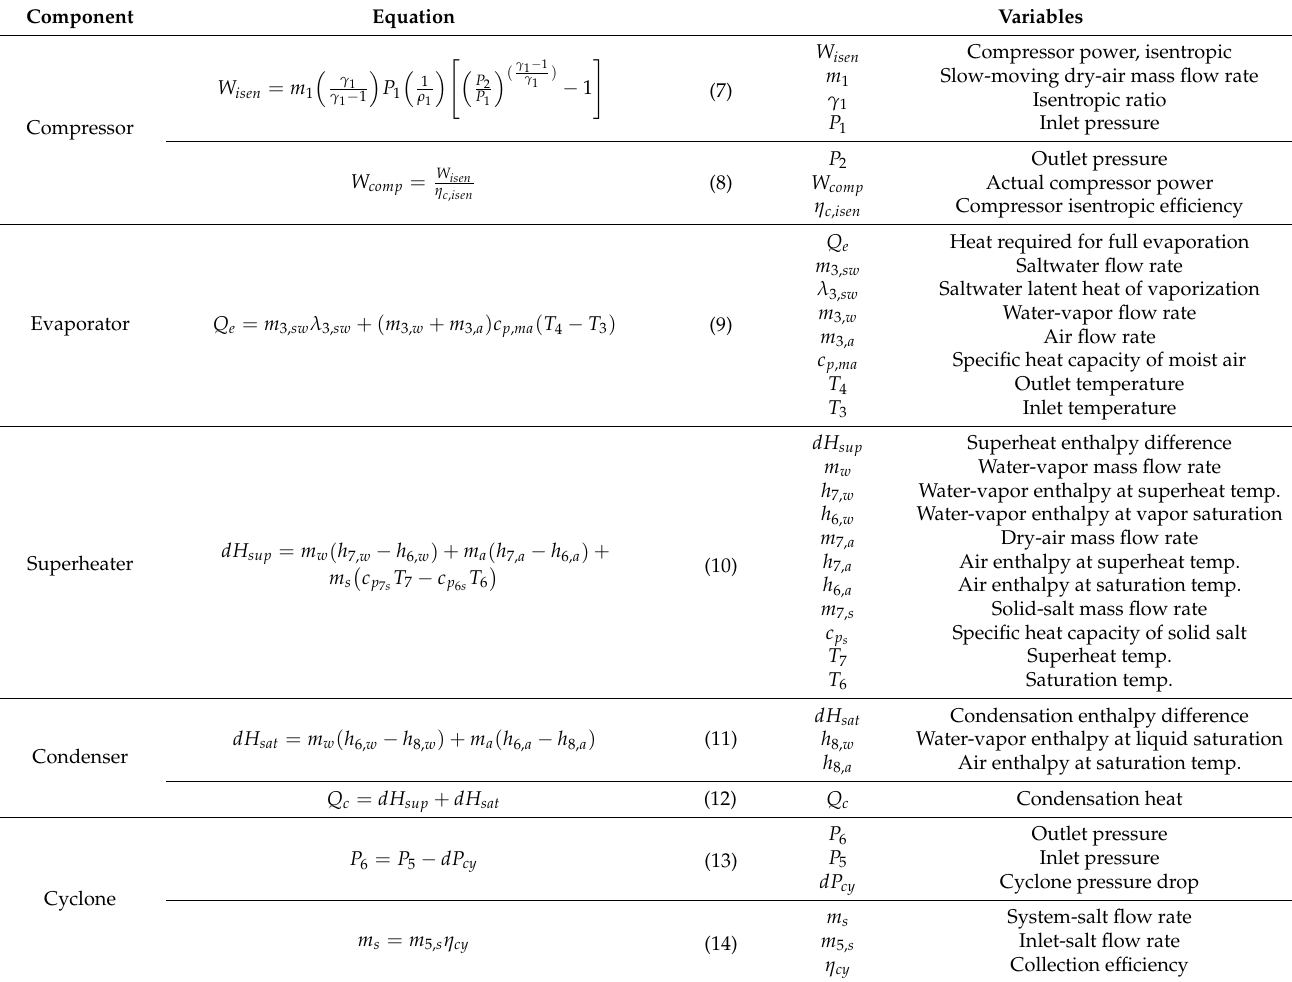
Table 1. Model Key